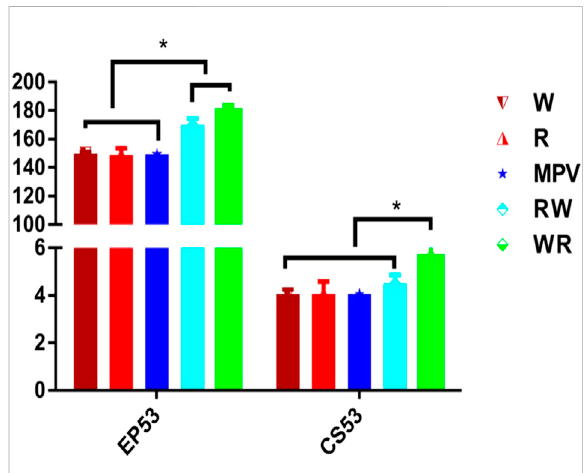
FIGURE 1 Egg number and clutch size at 53 weeks of age for parental lines and their reciprocal hybrids. Mean values with an asterisk (*) on top ofthem weresigni fi cantly different(Tukey-Kramer HSD p ≤ 0.05). W: Purebred White Leghorn, R: Purebred Rhode Island Red, RW: Rhode Island Red × White Leghorn cross, WR: White Leghorn × Rhode Island Red cross, MPV: Mid-parent